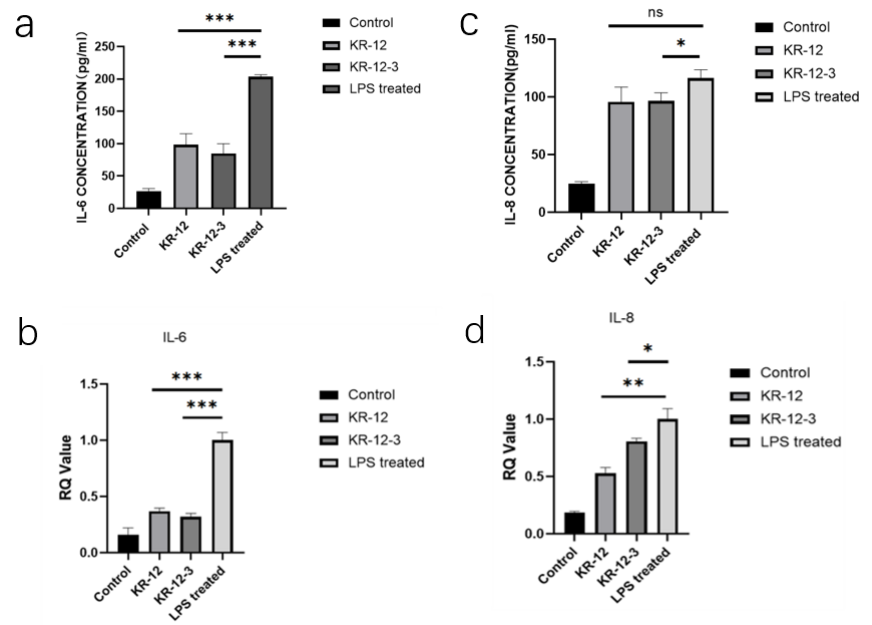
Figure 6. ( a , c ) Effects of peptides on LPS-induced production of IL-6 and IL-8 in RAW264. Cells were stimulated with LPS (100 ng/mL) for 24 h in the presence or absence of the peptide (20 µ g/mL). After culture, the concentrations of IL-6 and IL-8 in the culture supernatant were determined by enzyme immunoassay. The data are expressed as mean ± standard deviation of independent experiments, * p < 0.05 Compared with unstimulated macrophages; ** p < 0.01 compared with LPS-stimulated macrophages; *** p < 0.001 compared with LPS-stimulated macrophages. ( b , d ) Effects of peptides on IL-6 and IL-8 expression in LPS-stimulated RAW264 cells. Cells were stimulated with LPS (100 ng/mL) for 24 h in the presence or absence of peptides. The total mRNA was isolated, and the mRNA expressions of IL-6 and IL-8 were detected by RT-qPCR. Data were expressed as mean ± standard deviation of three independent experiments. ** p < 0.001 compared with unstimulated macrophages; * p < 0.05 compared with LPS-stimulated macrophages. The experiments were all repeated at least 3 times.